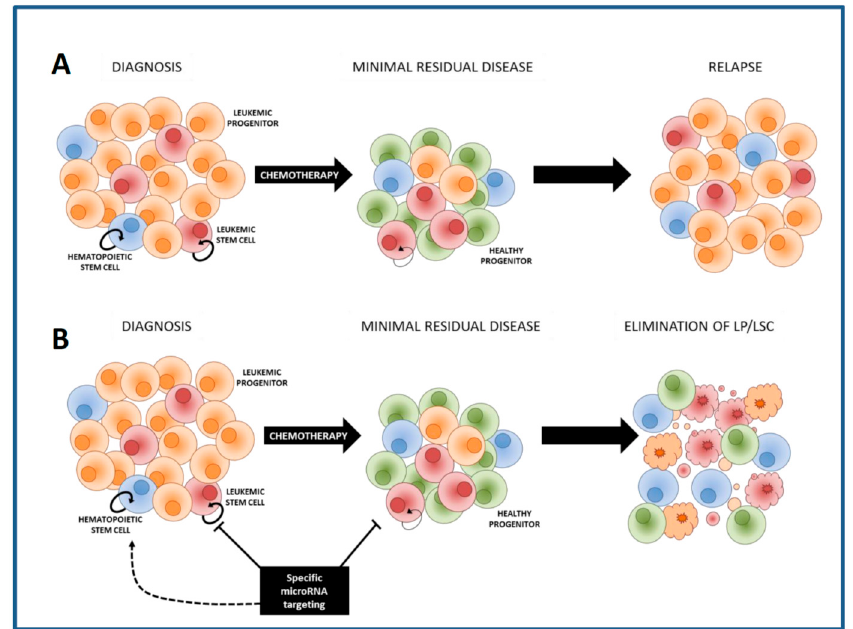
Figure 1. Role of LSCs in relapse development. At diagnosis, AML consist of a heterogeneous population of leukemic (stem) cells and residual normal hematopoietic (stem) cells. ( A ) Treatment with chemotherapy often results in complete remission. However, small numbers of leukemic cells survive the treatment (minimal residual disease, MRD). MRD contains chemotherapy resistant LSCs, which have the capacity to re-initiate leukemia and form a relapse. ( B ) MicroRNA-based therapy in combination with chemotherapy could eradicate LSCs and leukemic progenitors (LP) while sparing, or stimulating, HSCs.